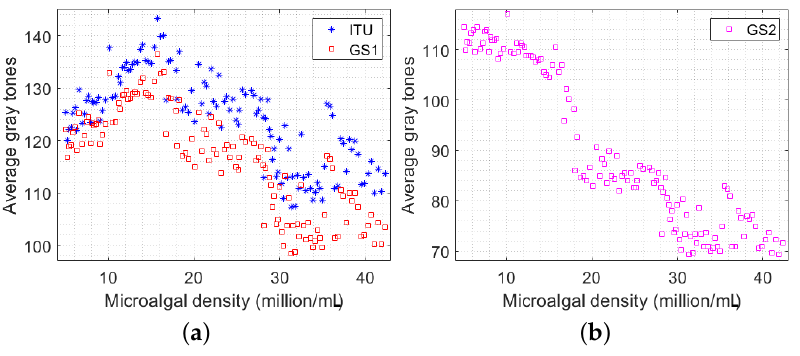
Figure 5. Grayscale average values of the microalgal images versus their corresponding densities, where the gray tones are converted based on ( a ) ITU [6,24] and GS1 [2] criteria and ( b ) GS2 [2]